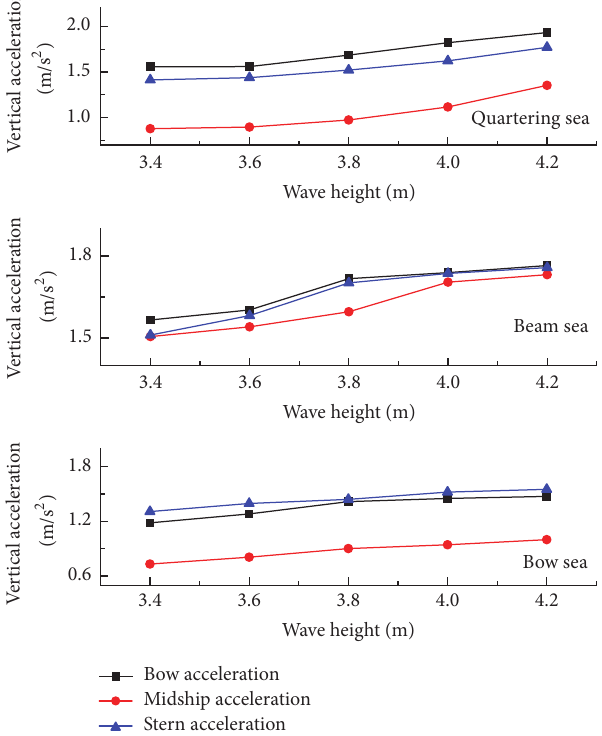
Figure 18: Results of acceleration in irregular waves.